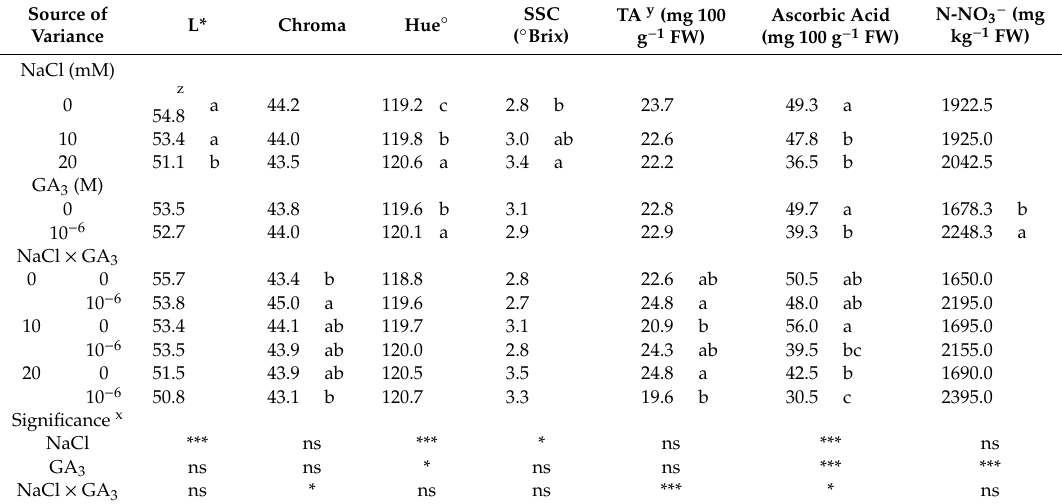
Table 4. Leaf color and chemical characteristics of leaf lettuce plants grown in nutrient solutions containing di ff erent levels of NaCl and GA 3 .